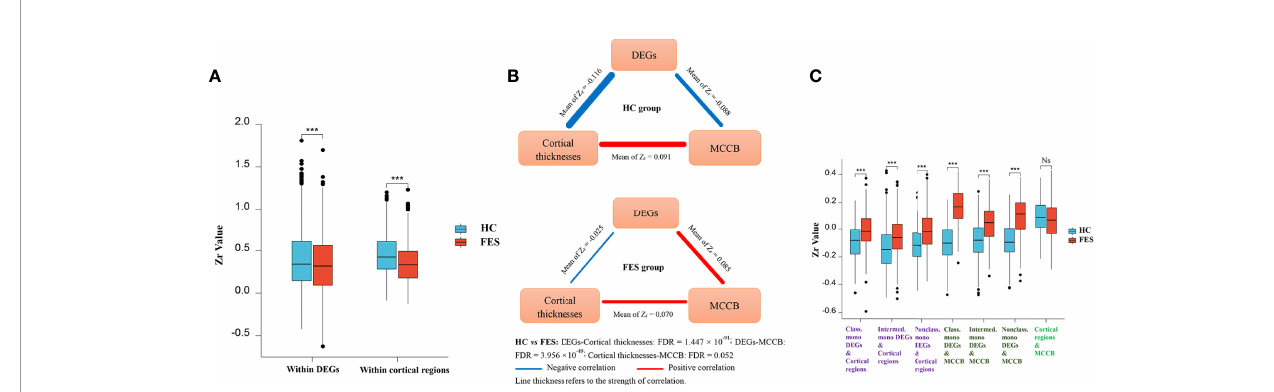
FIGURE 4 | Monocytic DEG mRNAs, cortical thicknesses, and cognition show differential correlations among each other in FES patients and HCs. Partial correlational analyses of the 54 monocytic DEGs normalized RNAseq counts, the averaged thicknesses of the bi-hemispheric 34 brain cortical regions, and the MCCB subscores, controlled for age, sex, and education years in HCs and FES patients, respectively. All partial correlation coef fi cients were transformed into Fisher Z r . The intra-associations within the monocytic DEGs module and the brain regions module (A, Mean ± SD shown, *** p < 0.001 ) , as well as inter-relationships among the three modules (B) , including DEGs re fi ned to different monocytic subsets (C, Mean ± SD shown, *** FDR < 0.001, Ns: Not signi fi cant ) , were compared between the two groups. HVLT: Hopkins verbal learning test; BVMT: brief visual-spatial memory test; CPT: continuous performance test; SOPT: speed of processing test; WMT: working memory test; EIT: emotion intelligence test; MAZET: mazes test. See also Supplementary Figures 1A, B